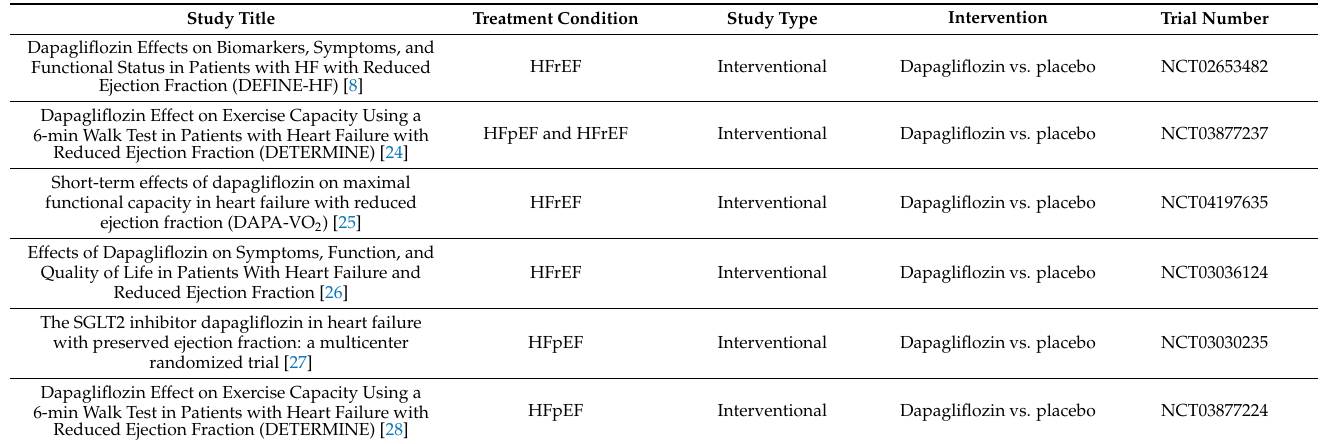
Table 1. List of clinical trials evaluating the effect of dapagliflozin on exercise capacity in patients with heart